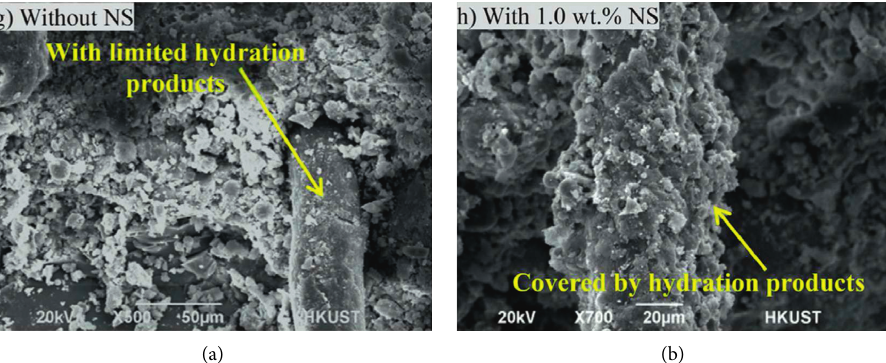
Figure 21: SEM images of a microfiber-modified HVFA mortar with and without NS, reproduced from [44], with permission from Elsevier,